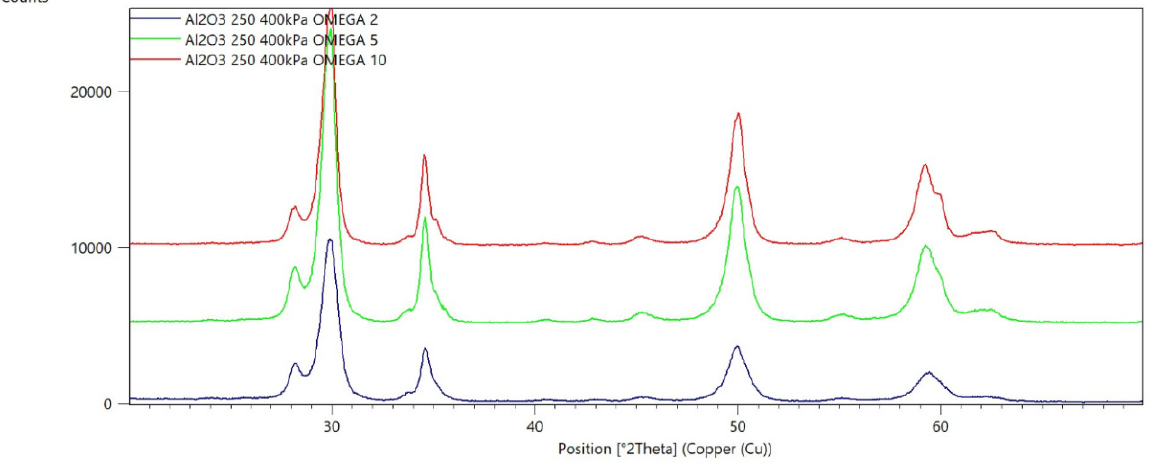
Figure 7. Diffraction patterns of sample F (abrasive—Al 2 O 3 250 µ m, pressure 400 kPa).